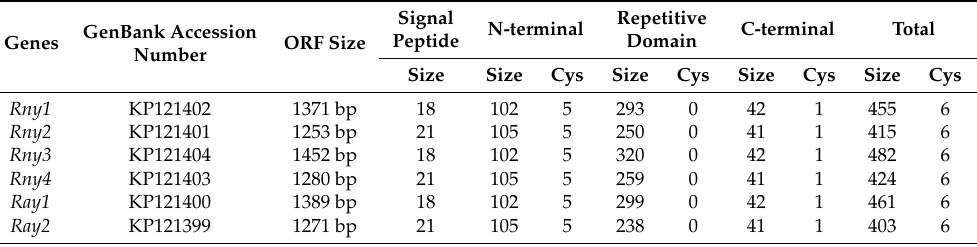
Table 1. A summary of some information of the six new HMW-GS genes from R. nakaii and R. alashanica . Signal GenBank Accession Genes Number